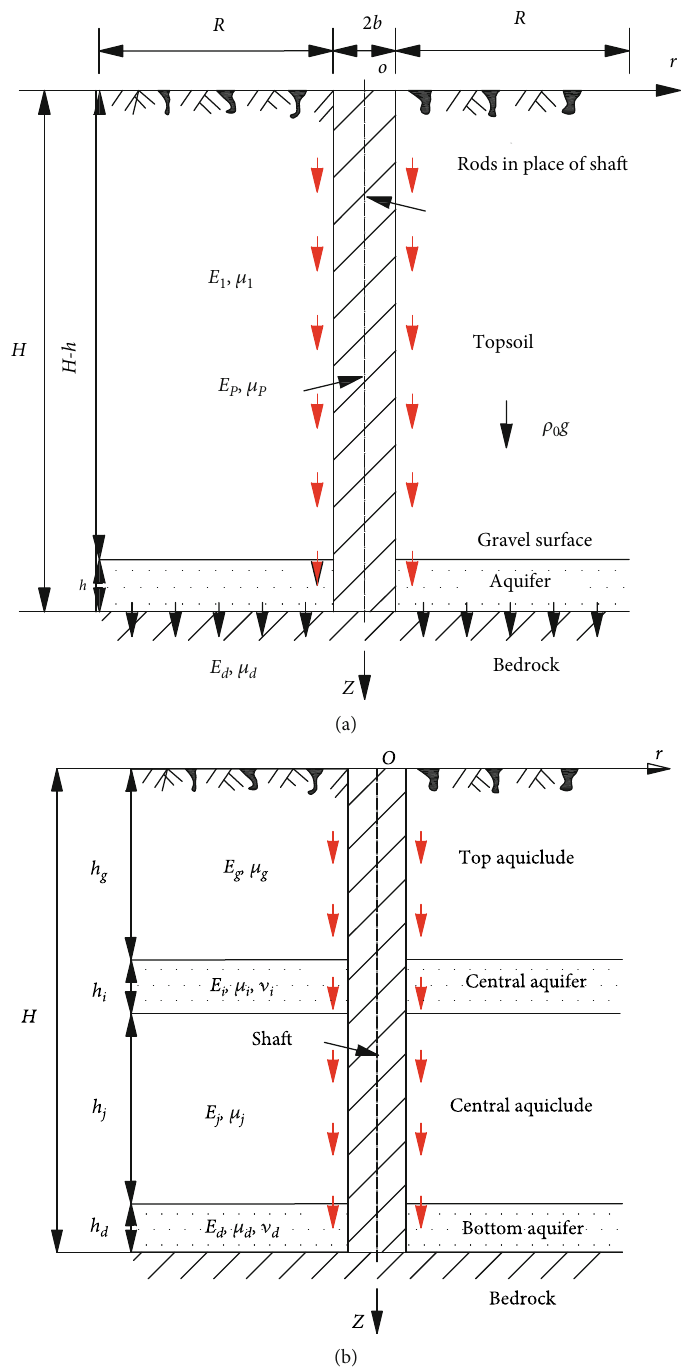
Figure 2: Schematic diagram of shaft and surrounding strata: (a) single bottom aquifer; (b)